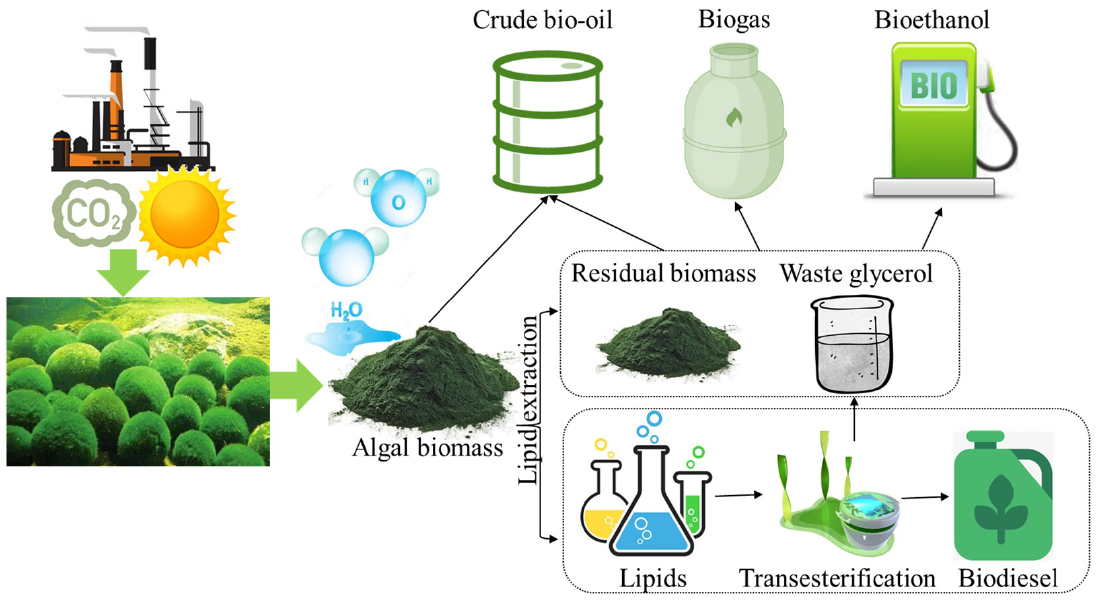
Figure 1. The general processing pathway of bioenergy production from microalgal biomass consid- ering microalgal